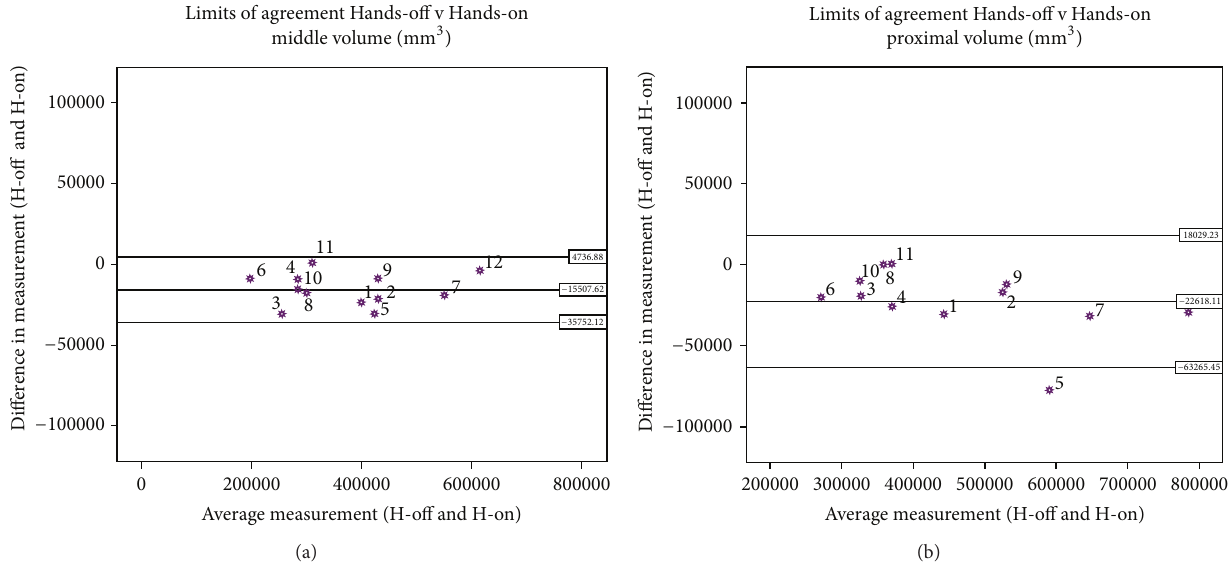
Figure 6: Bland and Altman plot for intercast volume of middle (a) and proximal (b)